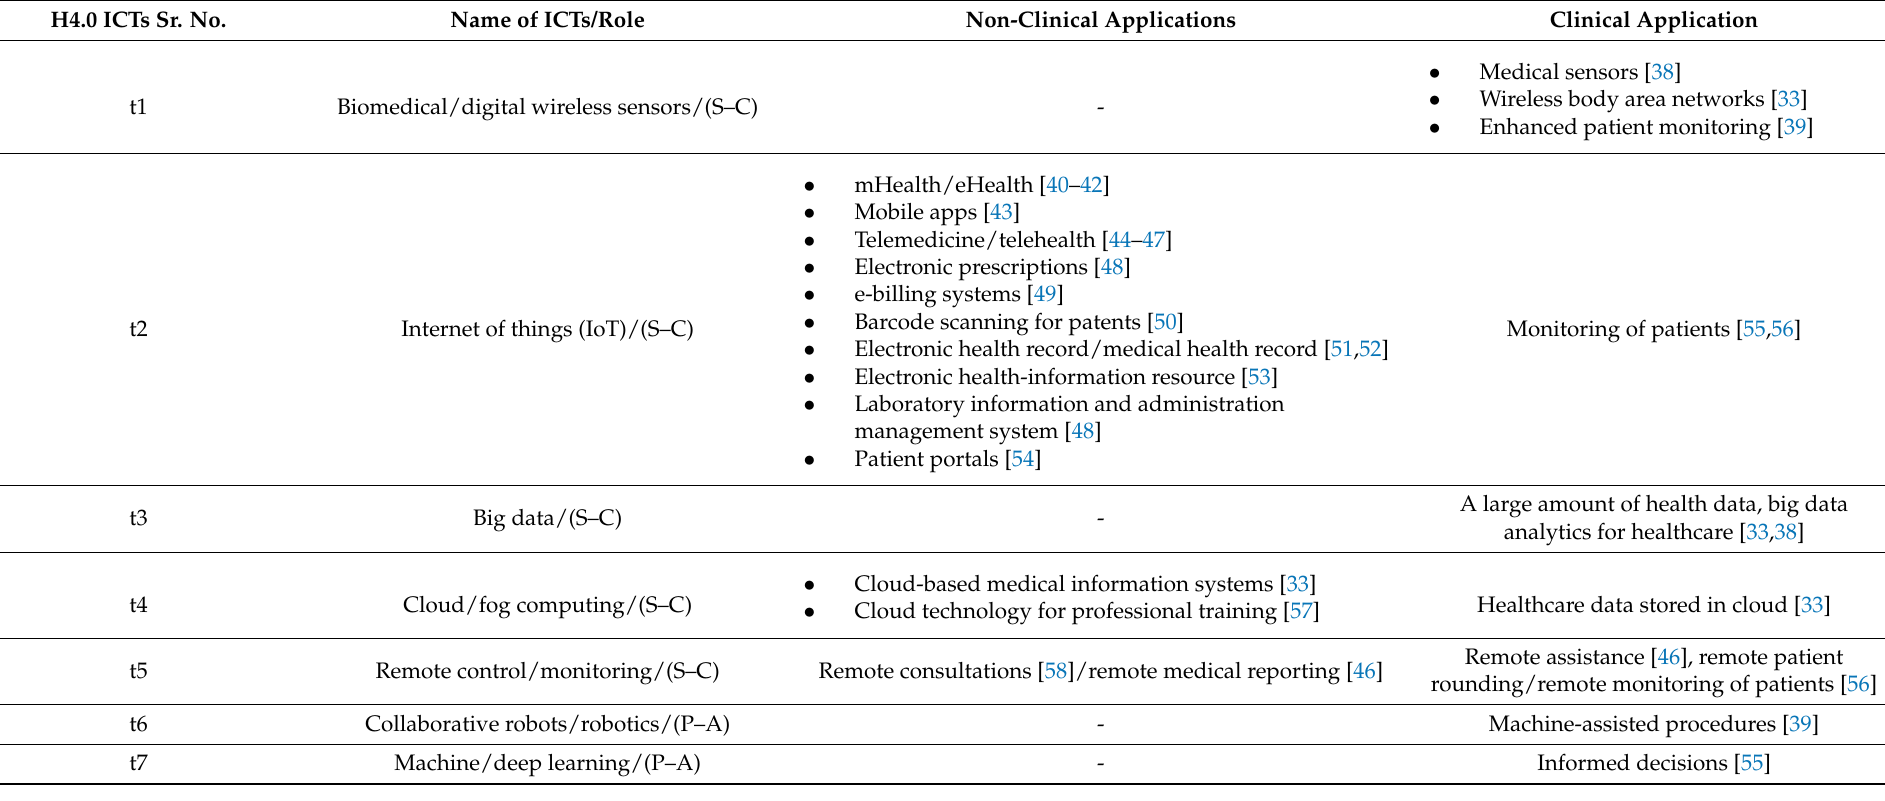
Table 6. Healthcare 4.0 ICTs, role, and